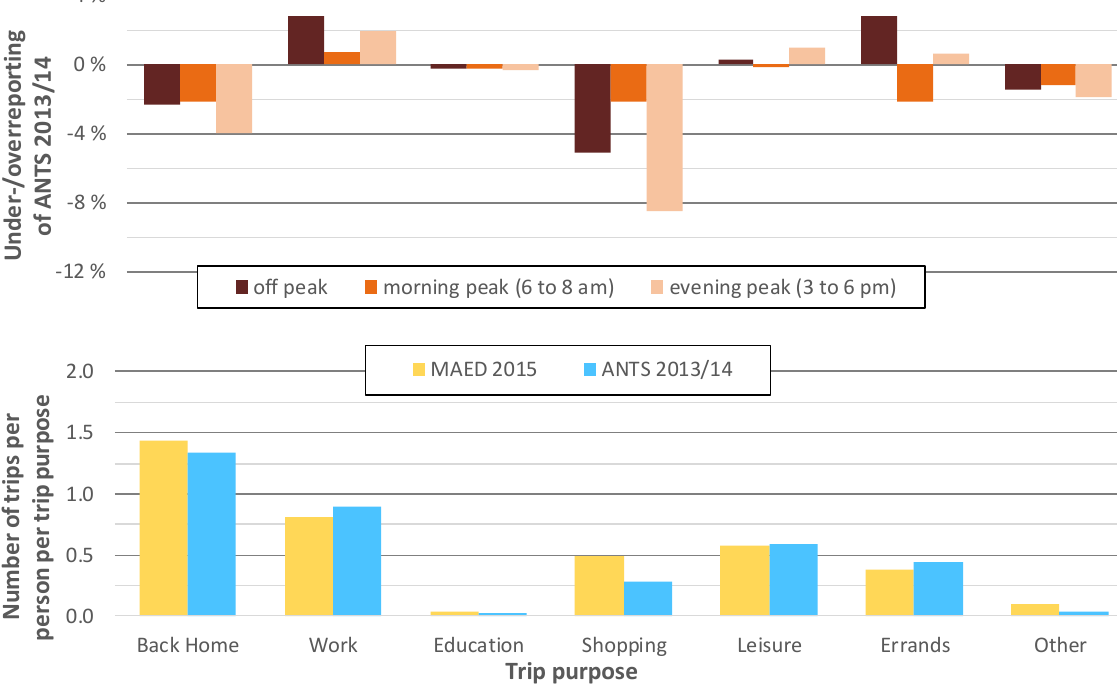
Figure 7. Distribution of trip purposes of all trips per person per day (below) and respective under- /overreporting of ANTS 2013/14